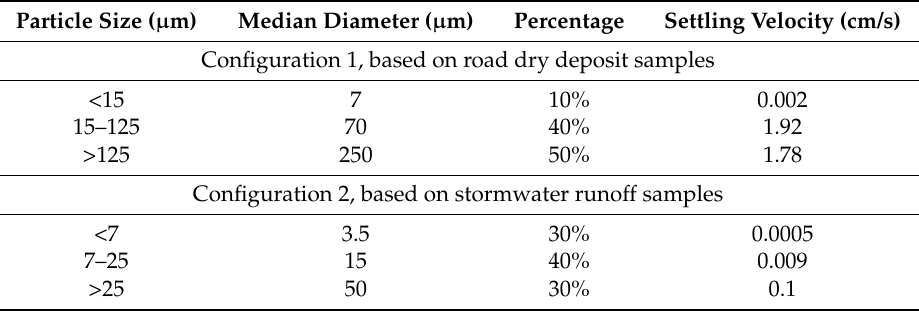
Table 4. Two configurations of different particle size